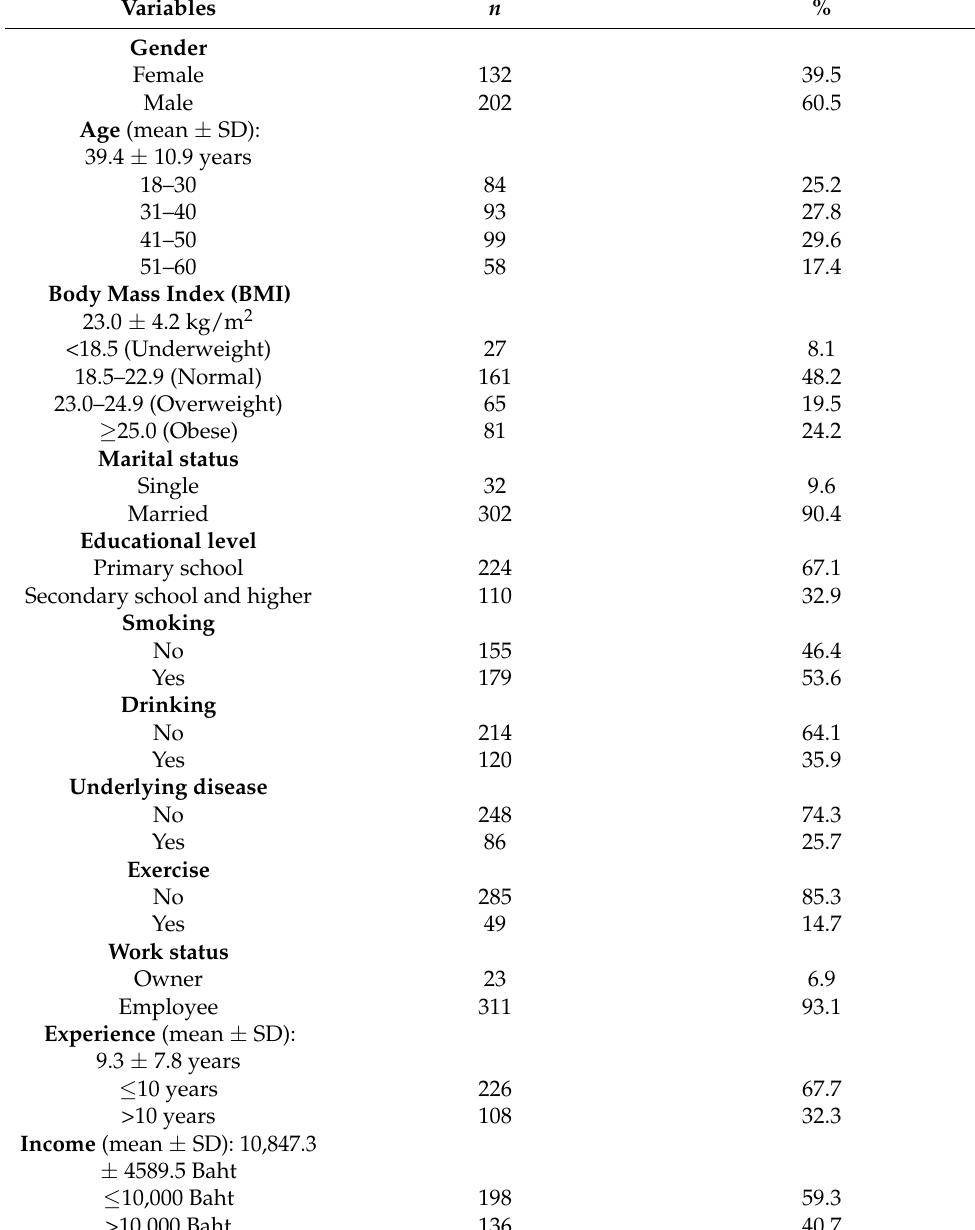
Table 1. Demographic characteristics of all participants ( n = 334).